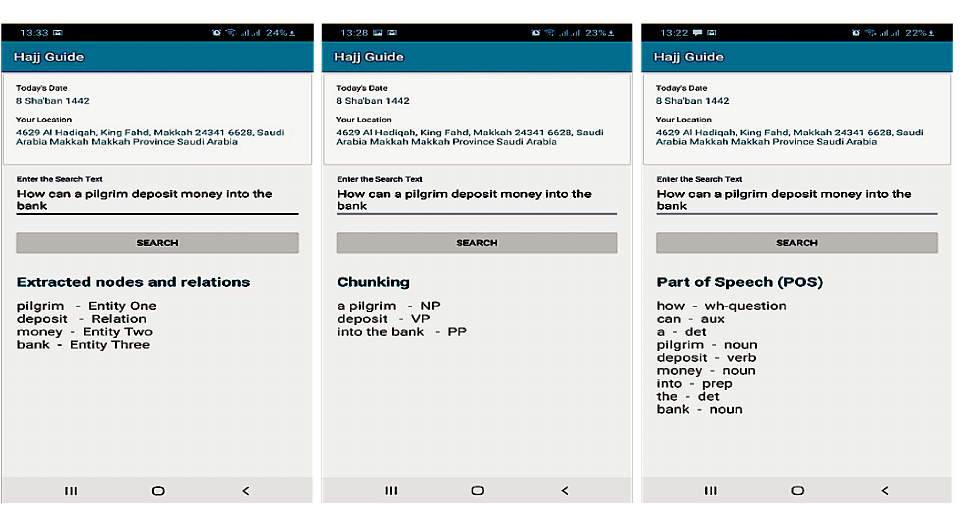
Figure 5. Syntactic processing tasks of a posed NL question via UI of a mobile application QA prototype. These include: Entities/Relations extractions, Chunking, and